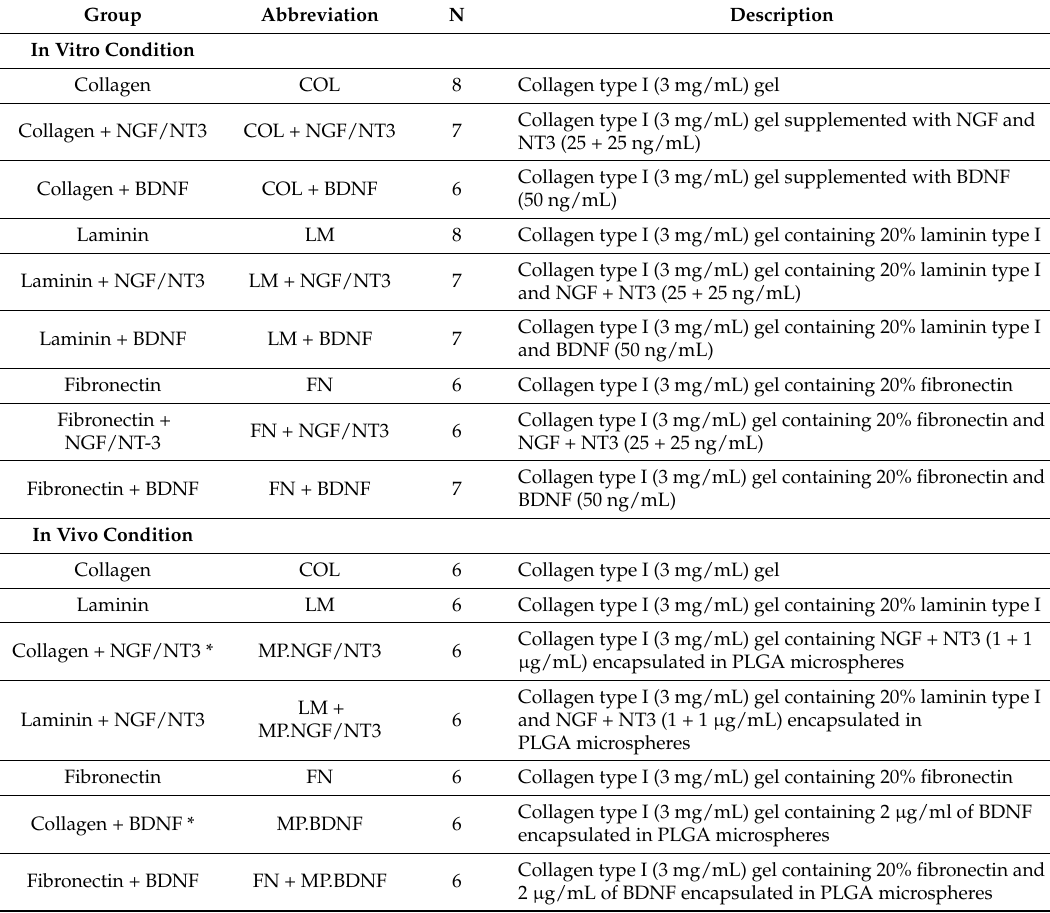
Table 1. Experimental conditions evaluated in the in vitro and in vivo studies. Group Abbreviation N